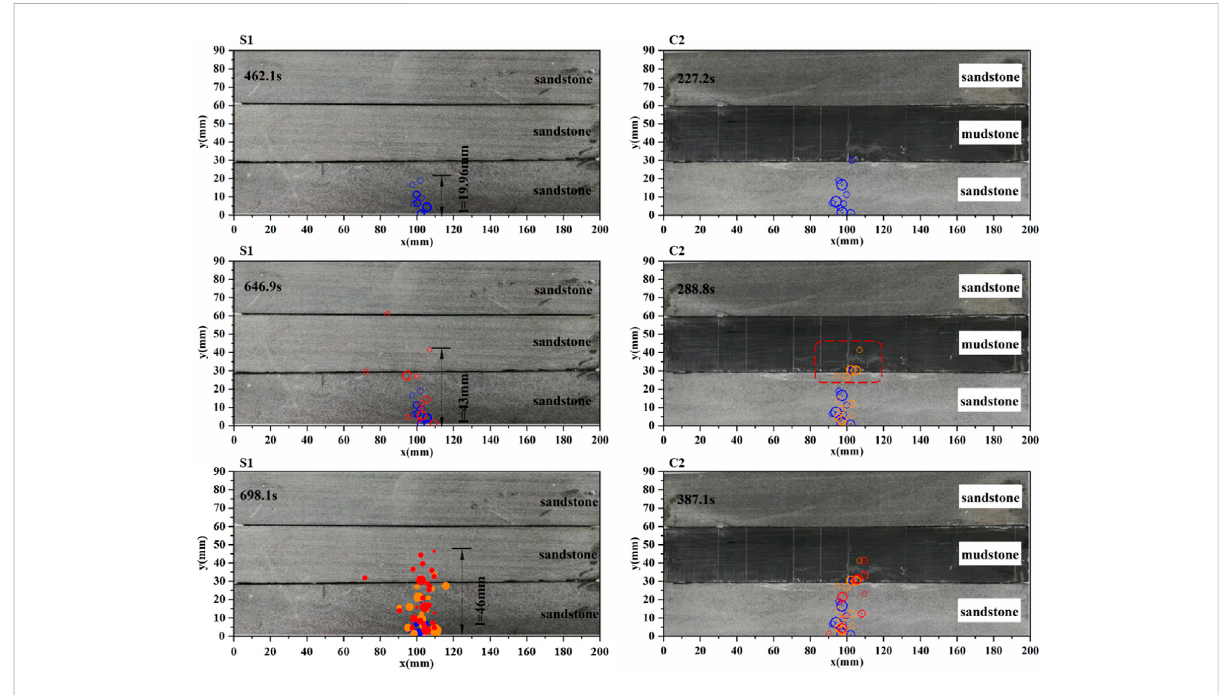
FIGURE 5 Acoustic emission positioning of A1 and C2 specimens.